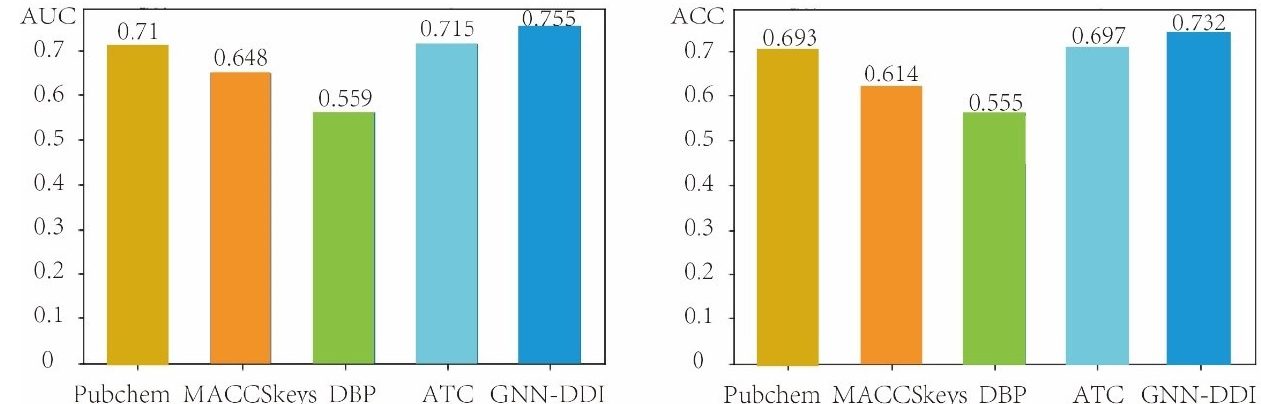
Figure 6. Comparison results of GNN-DDI with four other methods in the second DDI prediction scenario.